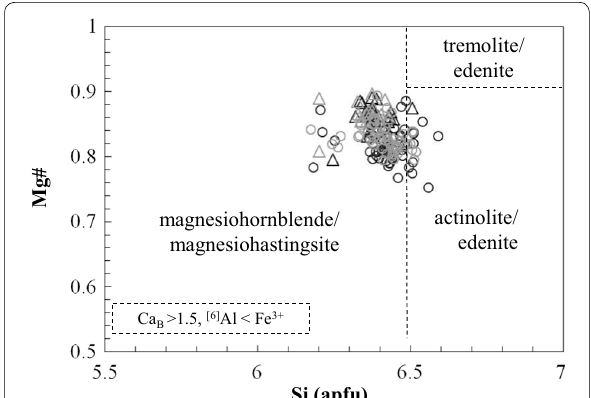
Fig. 3 Mg# [ Mg/(Mg Fe 2 + ) on a molar basis] plotted against Si = + (atoms per formula unit) for amphibole phenocrysts. Diamonds and circles indicate amphibole phenocrysts in samples 4I-1w and 4I-1p, respectively. Black and gray symbols indicate the cores and rims of phenocrysts, respectively. Classification is based on Leake et al. (1997)